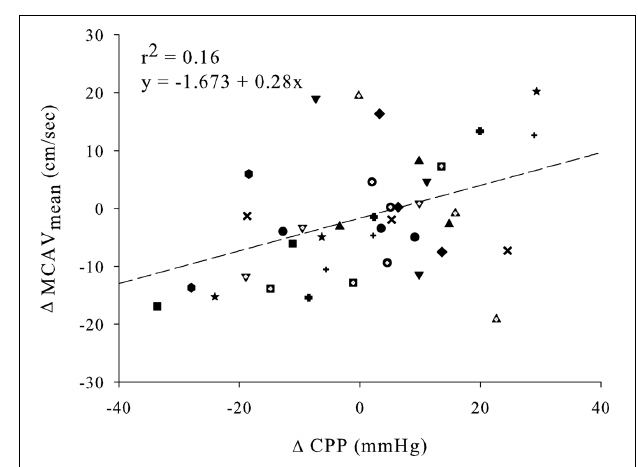
FIGURE 5 | Single linear regression plot of absolute change in MCAV mean and CPP. All subjects contributed three points in each regression line (during 30 and 70 degrees + 0 degrees after tilt back). The regression function is equal to y = − 1 . 673 − 0 . 28 x with corresponding correlation coefficient of r 2 = 0 . 16 ( p = 0 . 007). MCAV mean , mean middle cerebral artery flow velocity; CPP, cerebral perfusion